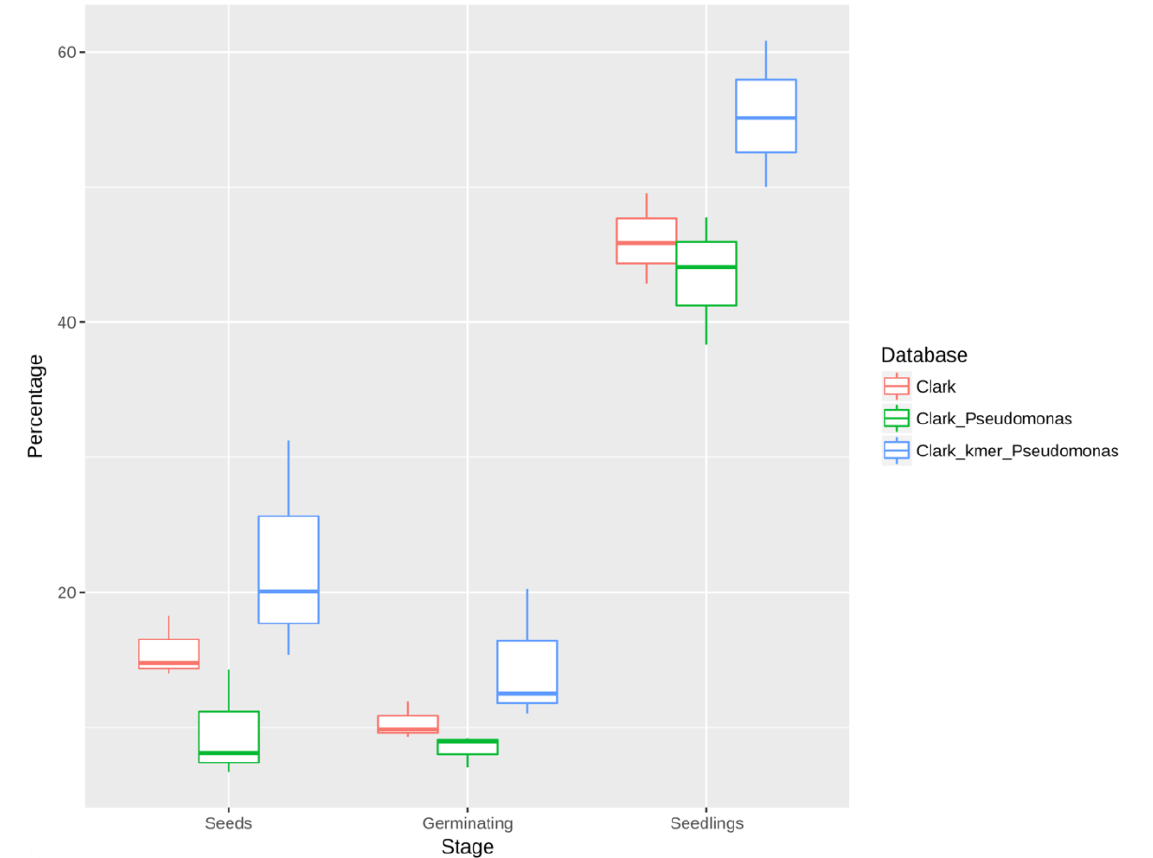
Figure 4. Percentage of classified reads. Classification of metagenome read sets derived from bean seeds, germinating seeds and seedlings with Clark (Ounit et al. 2015). Three distinct databases were employed for read classification: the original Clark database (red), Clark database supplemented with 3,623 Pseudomonas genome sequences (green) and the Clark database supplemented with 3,623 Pseudomonas genome sequences that were classified according to their percentage of shared k-mers (blue).